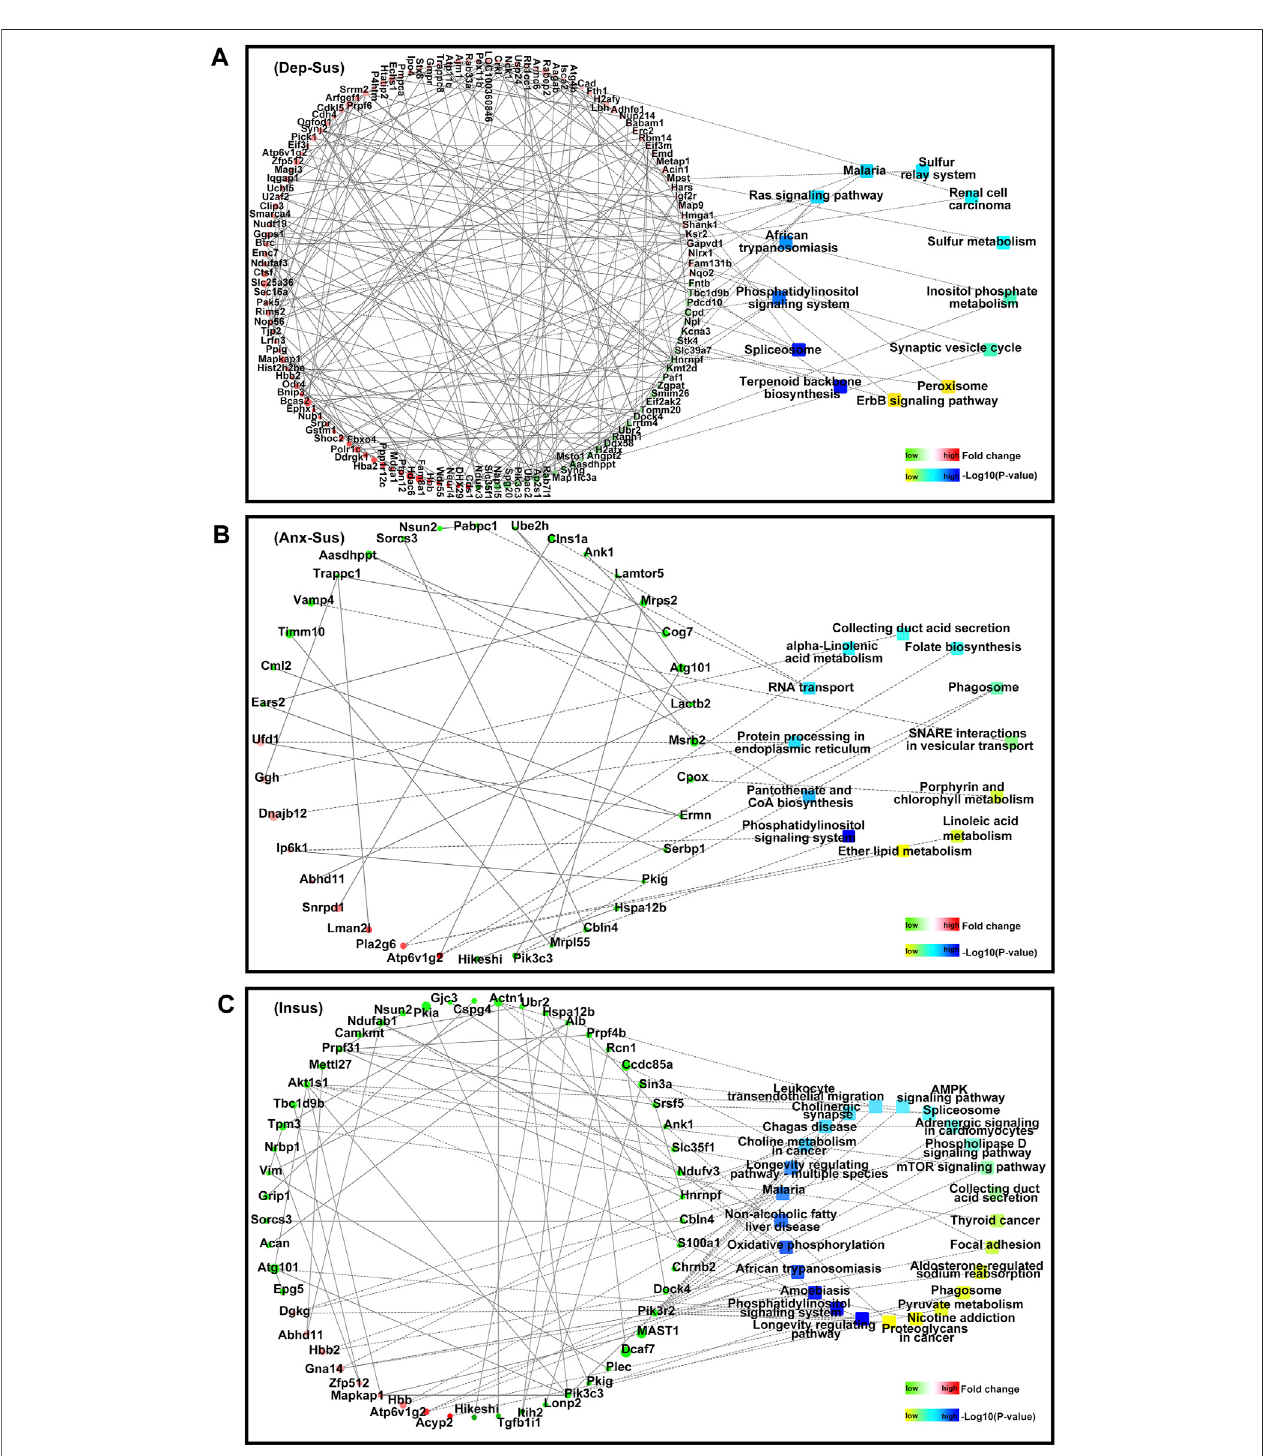
FIGURE 4 | PPI network map of the abnormally expressed proteins from the three groups [Dep-Sus, (A) ], anxiety-susceptible [Anx-Sus, (B) ], and insusceptible [Insus, (C) ]. The PPI networks were built based upon changes of protein expressions and enrichments of KEGG pathway terms. Circular nodes represent proteins/ genes, colored in green (downregulation) and red (upregulation). Their sizes are changed based on the negative log10 of p -values corresponding to protein expression changes. The rectangles represent KEGG pathways, colored with gradient colors from yellow (smaller p -value) to blue (larger p- value). The interactions between proteins/genes are indicated by solid lines or are otherwise displayed by dashed lines.